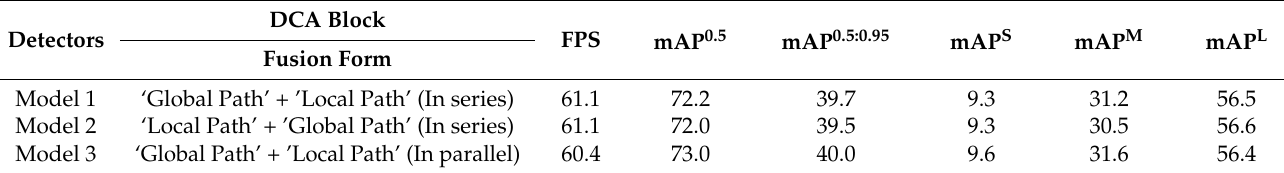
Table 5. Results of different fusion forms in DCA Block.